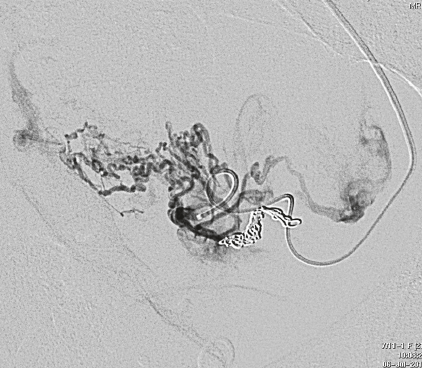
Figure 4: Pelvic angiogram—early arterial phase. Both internal iliac arteries (arrowed) show extensive abnormal arterial supply to the uterus, more evident on the left.